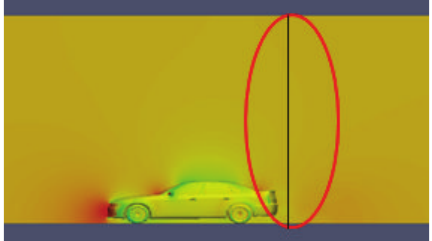
Figure 21: DrivAer model. Wake